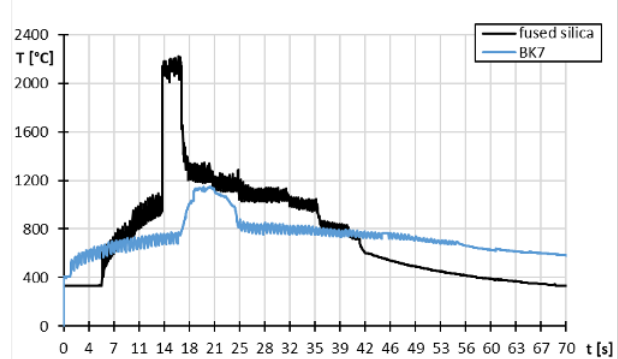
Fig. 4. Temperature-time curves for glasses with with high